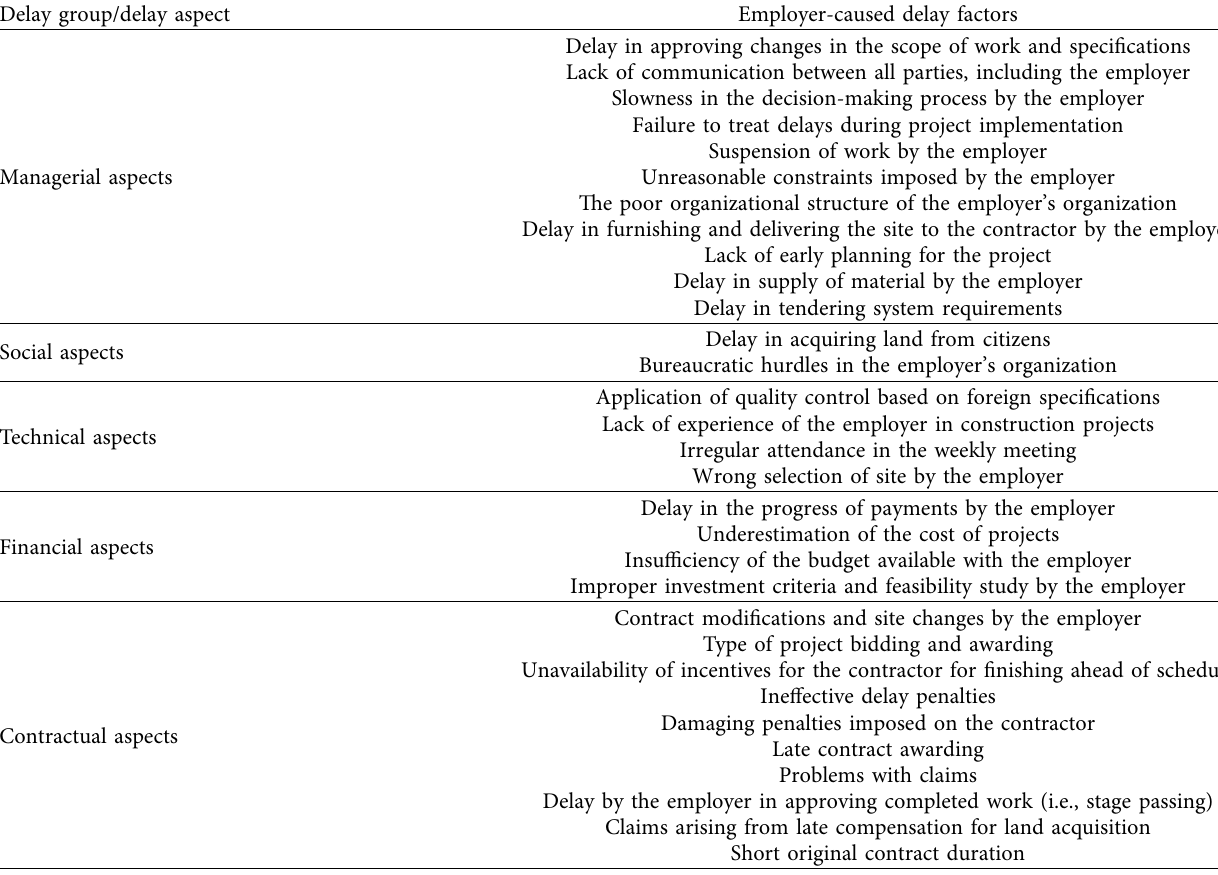
Table 9: Employer-caused delay factors sorted under the proposed delay aspects.